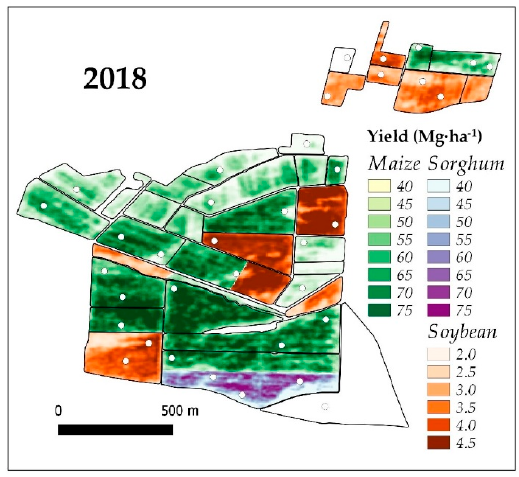
Figure 6. Crop yield maps of 2016, 2017, and 2018. The white parcels were not cultivated for that year